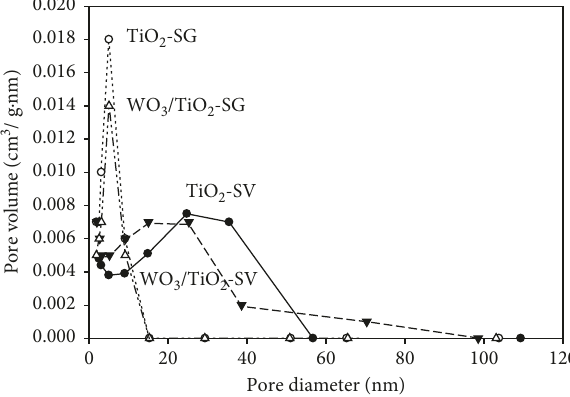
Figure 3: The pore size distribution for supports and